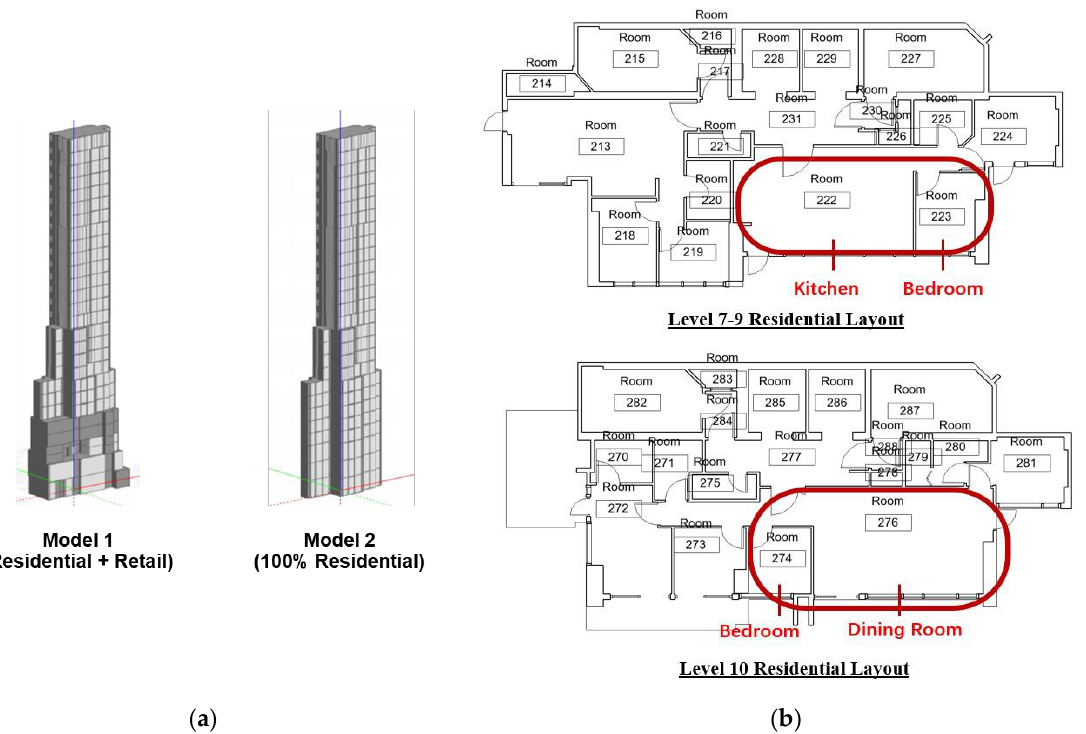
Figure 2. ( a ) Overview of Models 1 and 2 and ( b ) comparison of room layout for different storeys.